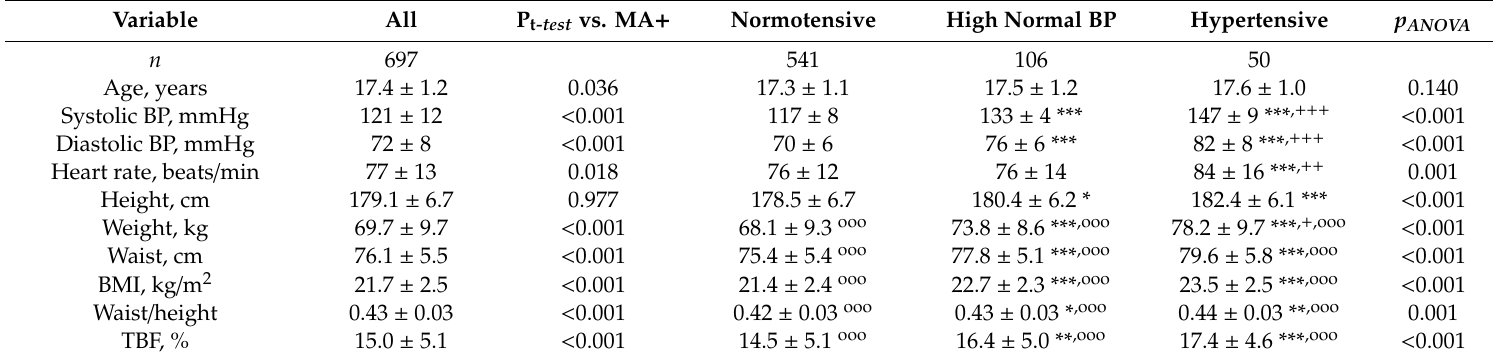
Table 5. Characteristics of males not presenting cardiometabolic